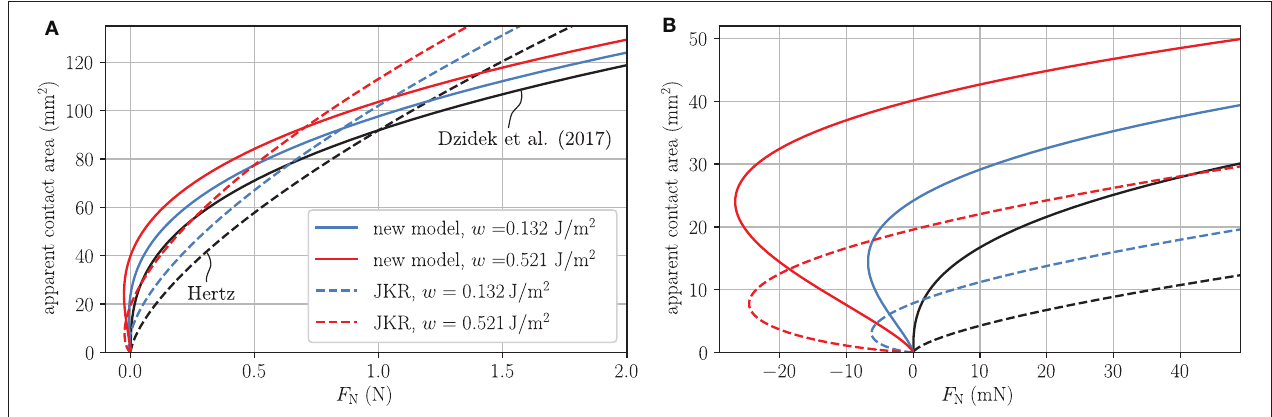
FIGURE 3 | Apparent contact area as a function of normal load for different works of electroadhesion; black curves represent the non-adhesive solution; (A) Plot over the whole loading range; (B) Enlarged view of the pull-off region associated with negative